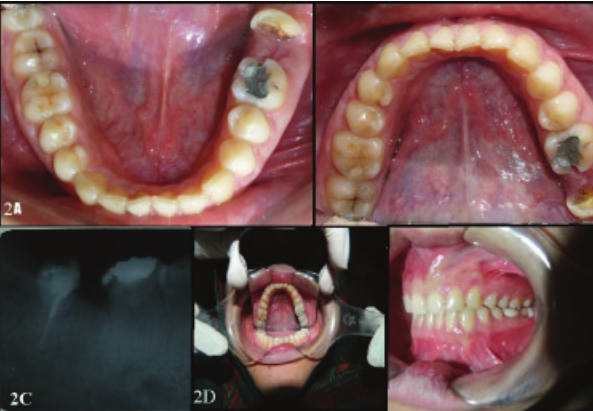
Figure-II: Healing after hemisection (A), Post placement (B), Post and core in distal root(C), Metal ceramic bridge (D), Centric Occlusion